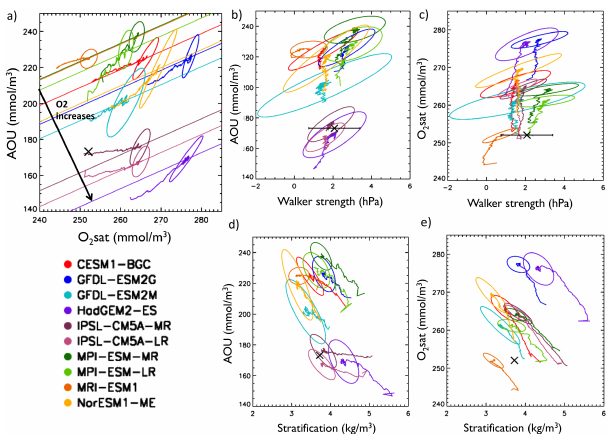
Figure 11. Interannual variability and climate-change trend in oxy- gen, AOU, and O 2 sat for each CMIP5 model (symbolized by colours explained in the legend) in the eastern Pacific (from 10 ◦ S to 10 ◦ N latitude and 115 to 60 ◦ W longitude) at a depth of 100 to 200m. Solid lines denote constant oxygen values (O 2 = O 2 sat– AOU) at the pre-industrial concentration. Each ellipse encompasses 95% of the interannual variability in O 2 sat ( x axis) and AOU ( y axis), calculated in a 100-year period of the control run (a) . The wiggly line shows the 20-year smoothed climate change evolu- tion from 1900 to 2099, starting from the centre of the ellipse and moving out of it as time passes. Observations are shown as a cross (WOA09). Subsequent panels show the effect of the Walker circu- lation strength on AOU (b) and O 2 sat (c) , and the effect of strati- fication on AOU (d) and O 2 sat (e) . Observed variability in Walker circulation is included in panels (b) and (c) (black line). The model HadGEM2-CC (not shown) shows results similar to